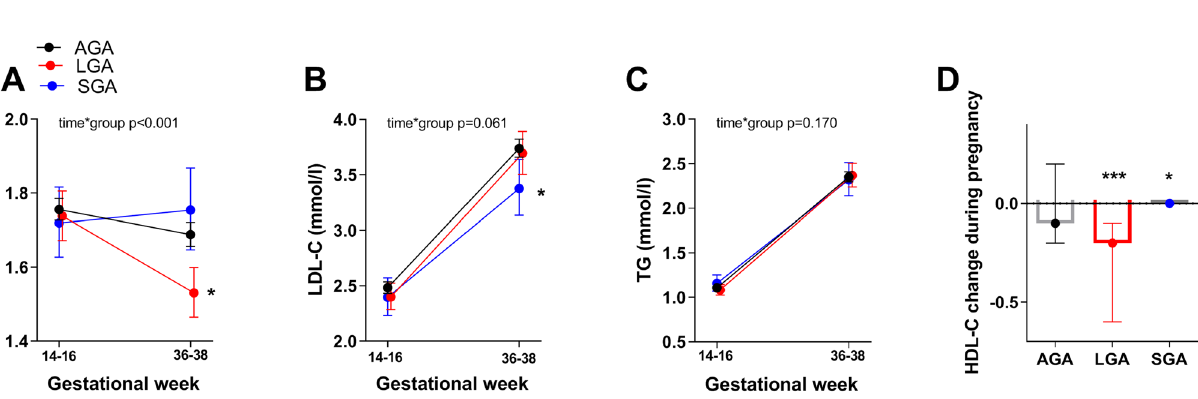
Figure 1. ( A–C ) Cholesterol and triglyceride levels at week 14–16 and week 36–38 during pregnancy between AGA (appropriate for gestational age) n = 731, LGA (large for gestational age) n = 135 and SGA (small for gestational age) n = 64 infants, adjusted for age and BMI at week 14–16. Data is given as estimated marginal means and 95% CI. ( D ) HDL change during pregnancy between AGA, LGA and SGA infants. Data is given as